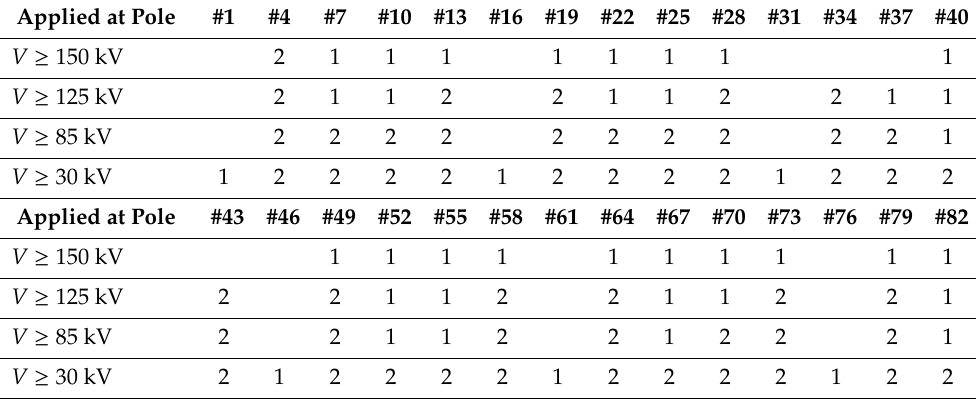
Table 8. Number of transformers with at least one phase reaching the critical overvoltage level. Case 3, wet creosote-impregnated poles, sub-configuration C3.1.